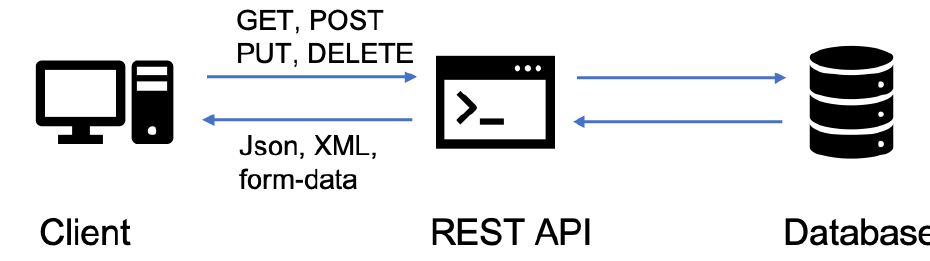
Figure 2. RESTful API communication concepts.